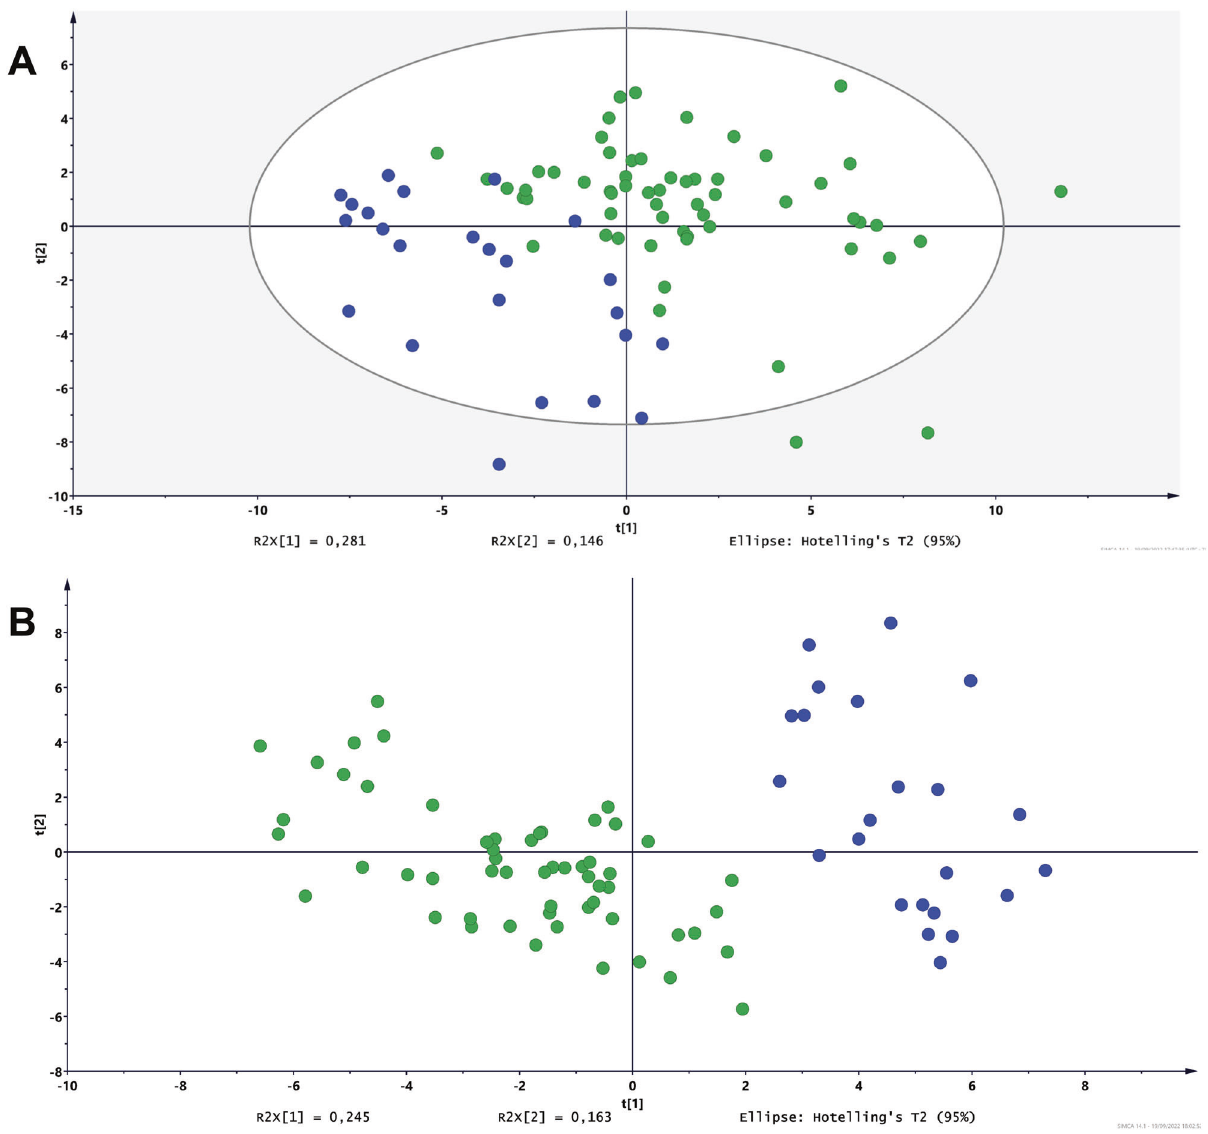
Fig. 1 Multivariate analysis of the head and neck paraganglioma patients (HNPGLs) and healthy controls (HCs) based on the metabolites detected by FIA-MS/MS. Panel A shows the principal component analysis (PCA) plot with the spatial distribution of the HNPGL patients and the HCs based on similarity. Panel B shows the partial least square discriminant analysis (PLS-DA) plot. Only few outliers situate outside the tolerance ellipses. Blue dots: HCs; green dots: